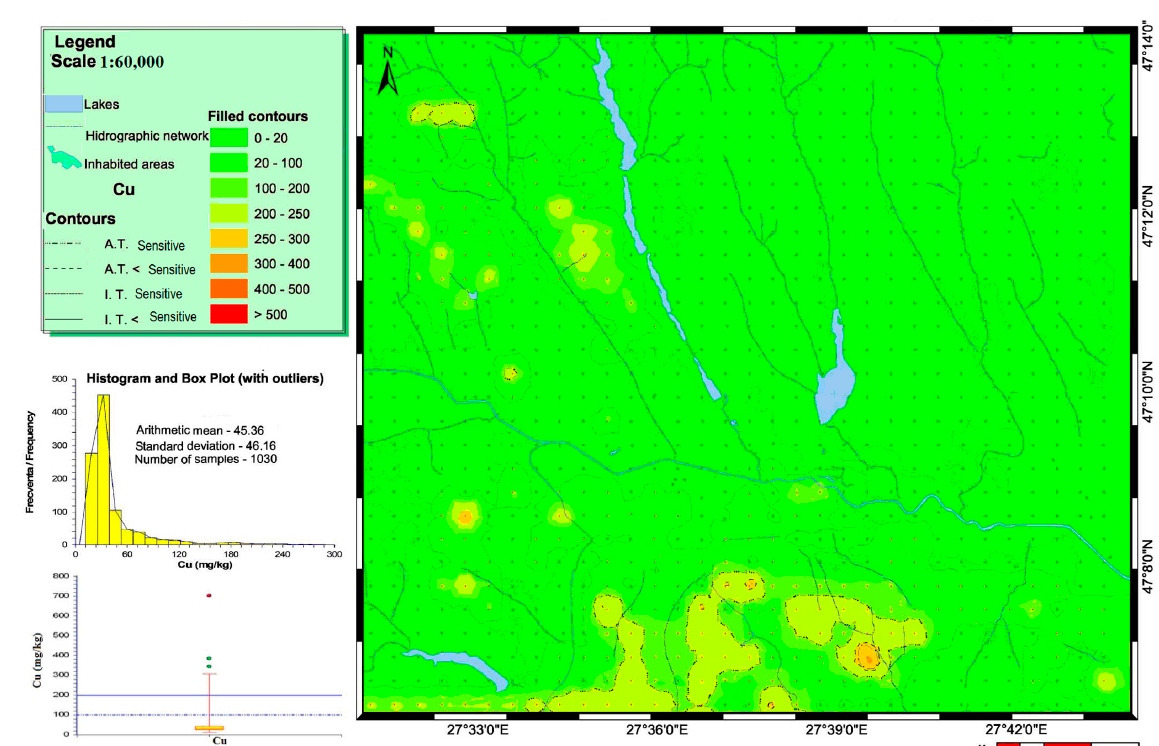
Figure 3. Map of Cu distribution in the analysed soil (mg kg − 1 ).